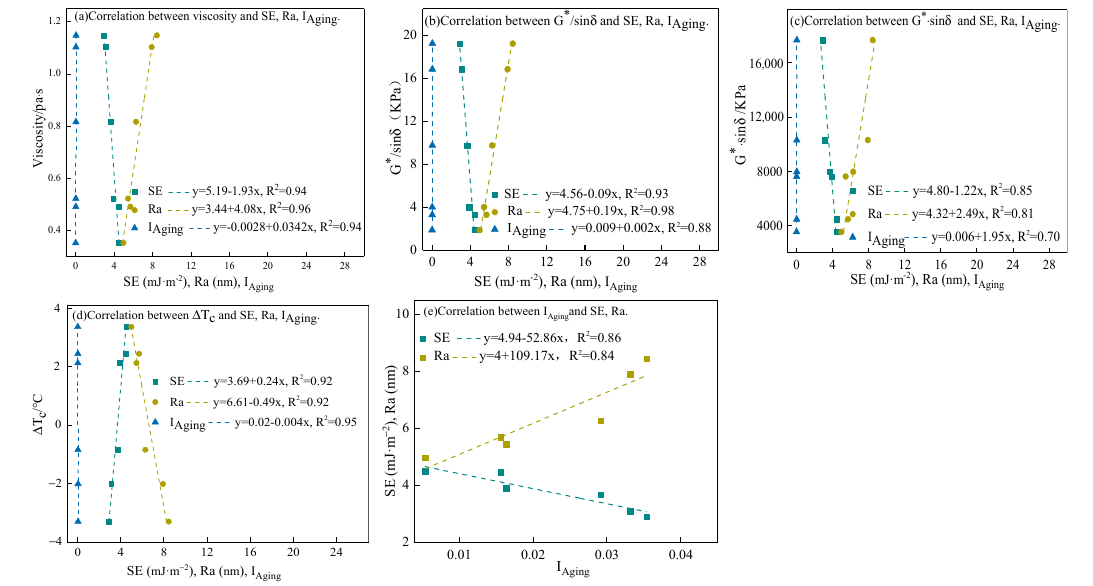
Figure 10. Correlation of rheological properties with microstructure.